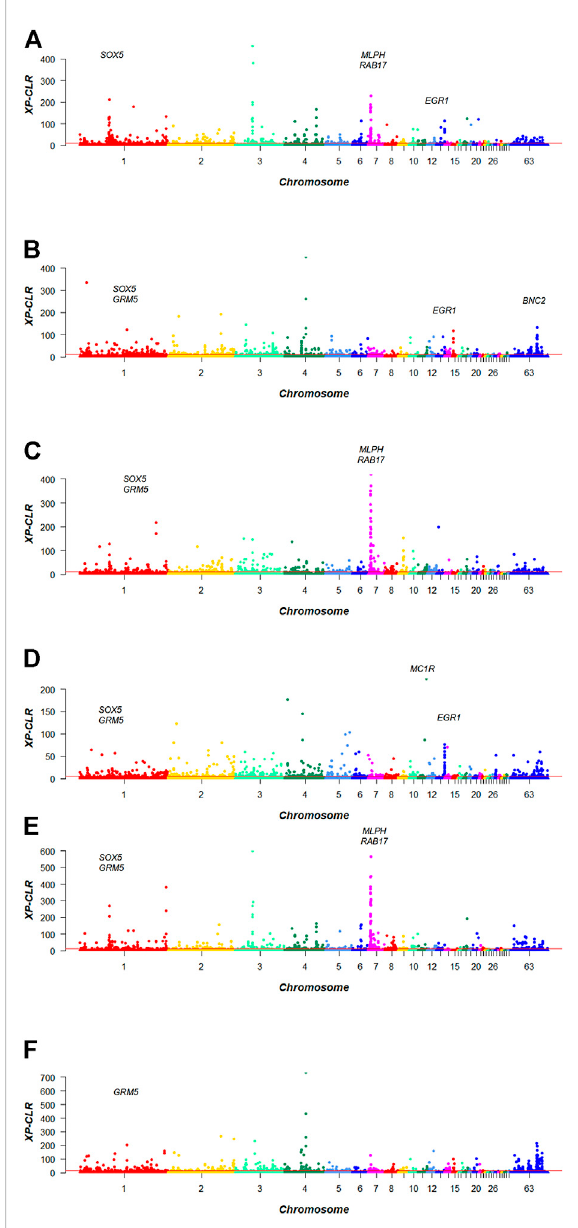
FIGURE 2 XP-CLR Mahattan plot of plumage colors in Baicheng You chicken. (A) Black vs . lavender; (B) black vs. yellow; (C) lavender vs. yellow; (D) black vs. lavender + yellow; (E) lavender vs . black + yellow; (F) yellow vs. black +